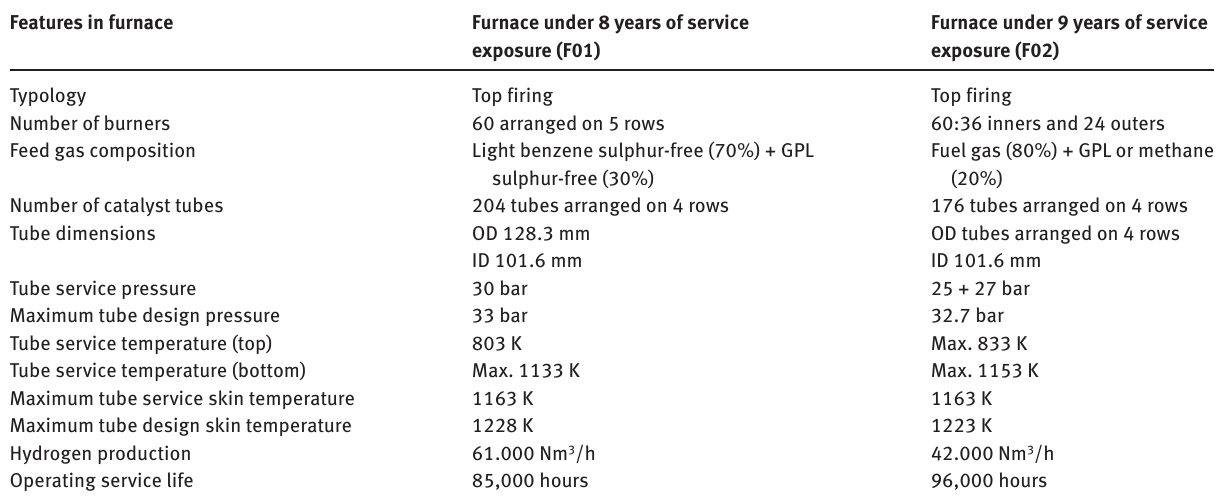
Table 11: Design data of two plants [32].